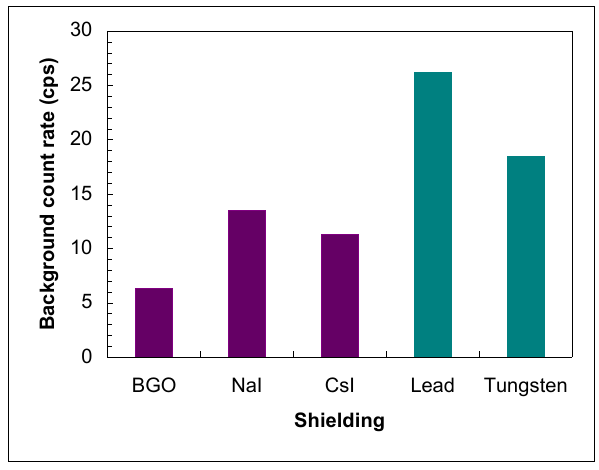
Figure 6. Background count rates for a cylindrical water cavity 40 cm long and 8.9 cm in diameter with 4 PMTs at each end operated in a single-ended coincidence mode. In each case, the shield is an annulus 1.27 cm in diameter. The three active shields considered were the scintillators BGO, NaI(Tl) and CsI(Na); lead and tungsten are passive shields.